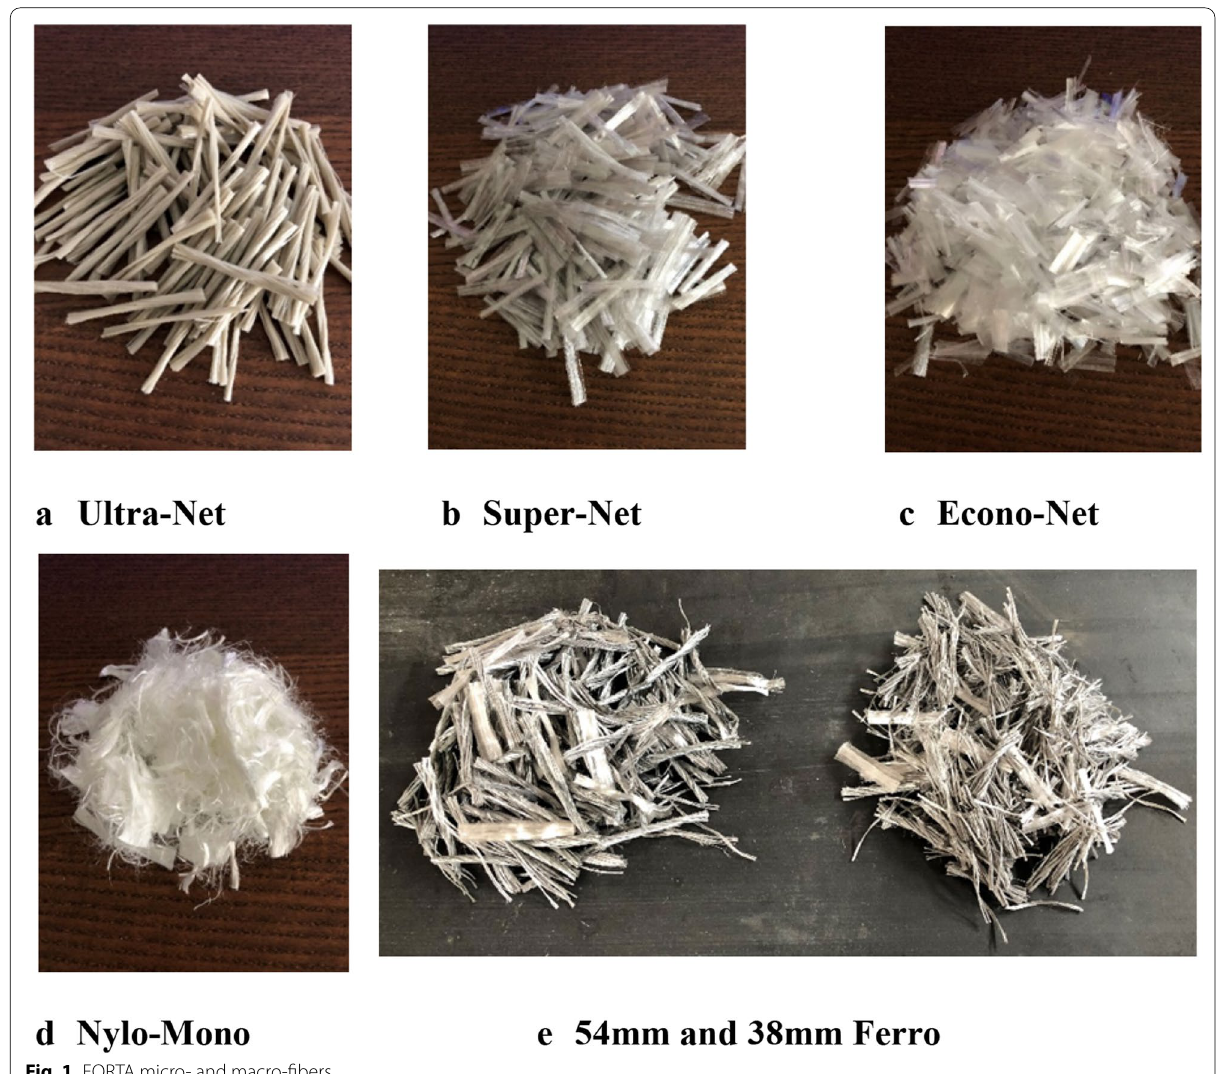
Fig. 1 FORTA micro- and